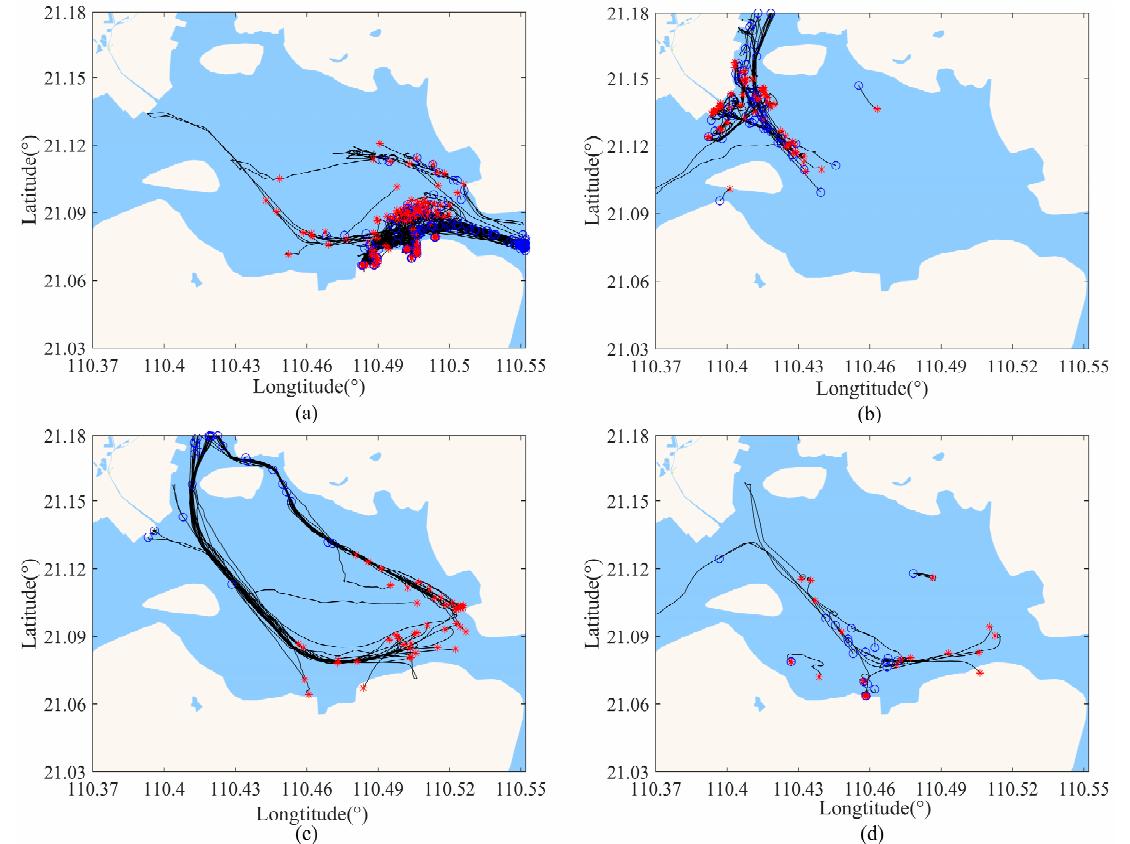
Figure 11. Trajectories with departures inside the port. ( a ) Area 2 to Area 1, 156; ( b ) Area 3 to Area 3, 71; ( c ) Area 2 to Area 4, 48; ( d ) Other trajectories in port, 24.